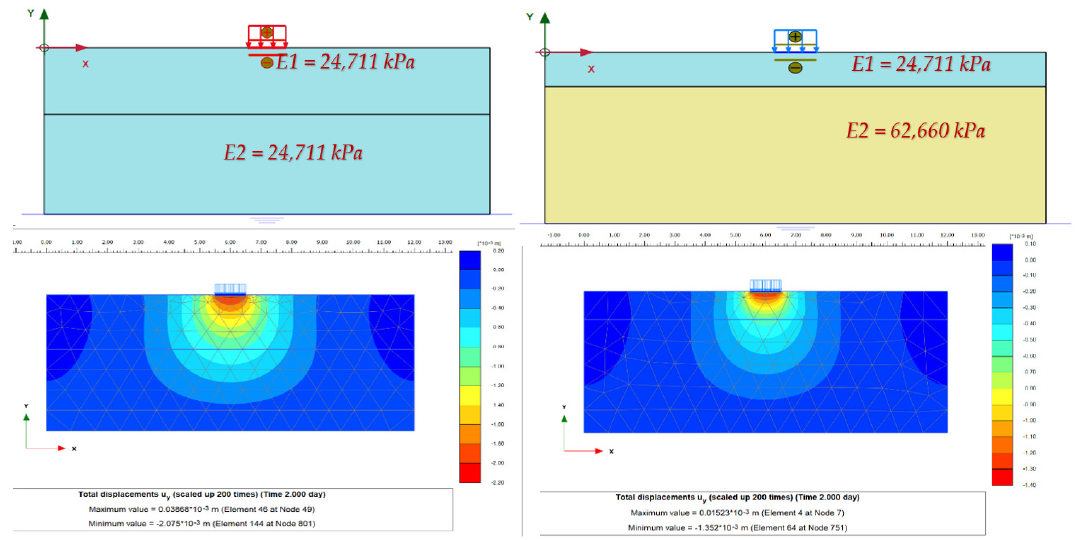
Figure 6. Effect of the stiffness of the layer.